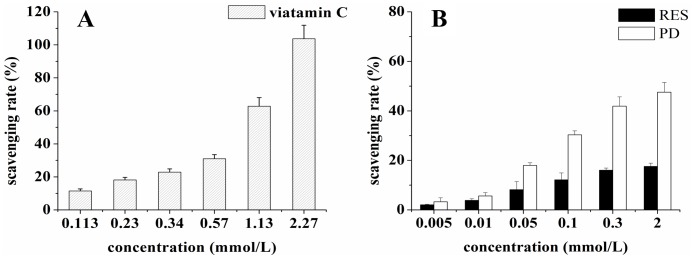
The hydroxyl radical scavenging capacity of vitamine C (panel A), resveratrol (RES) and piceid (PD) (panel B) in phenanthroline-Fe2+ system.